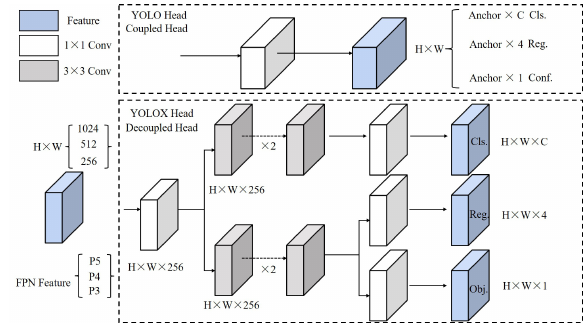
Fig. 1. Comparison of detection head structure between YOLOV3 V5 and YOLOX.